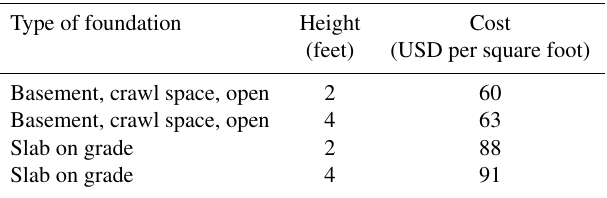
Table 6. Costs of the dry-proofing measures.